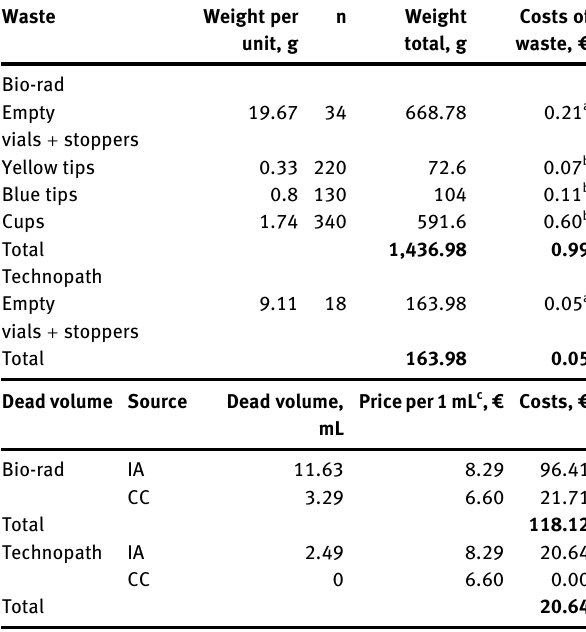
Table  : Summary of calculation of costs from ef fi ciency study on differentQCmaterialsover  days.(Forcalculationofthecosts,one has to consider that depending on the location and contracts, different pricing may occur, so we are reporting the prices listed for the QC material as well as for the